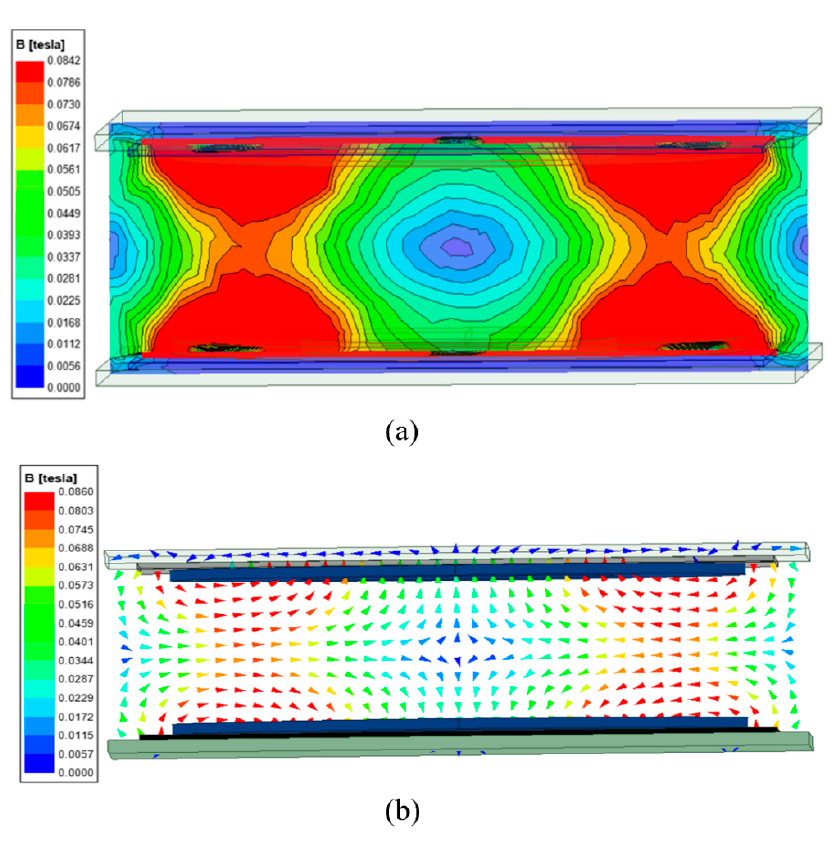
Figure 7. ( a ) Magnetic field distribution diagram, ( b ) magnetic field distribution (vectorial). Figure 7. (a) Magnetic field distribution diagram, (b) magnetic field distribution (vectorial).